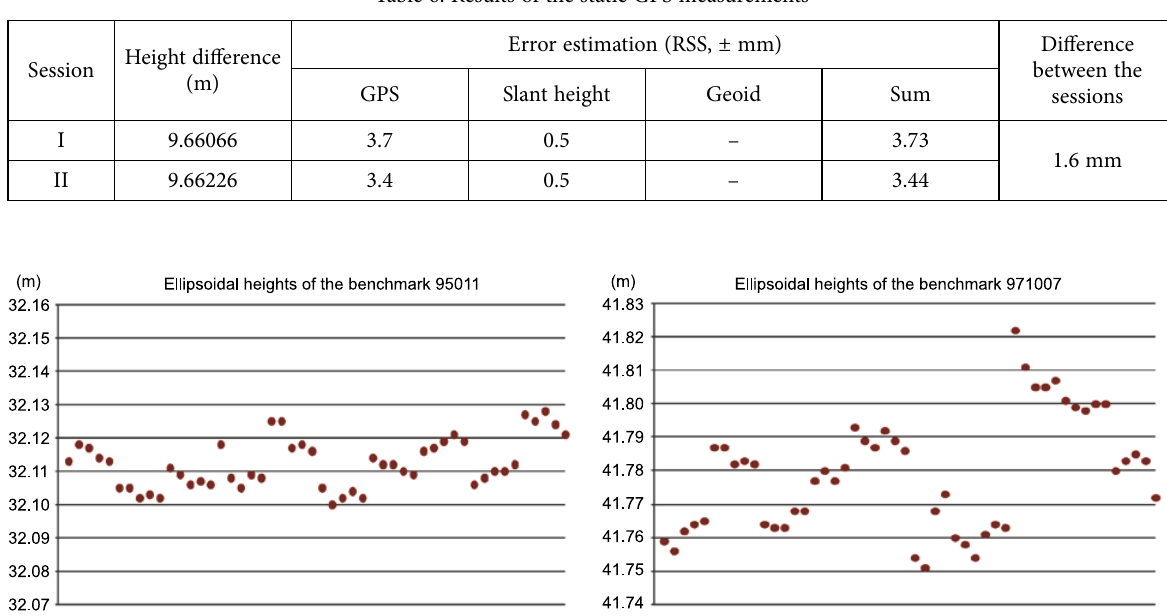
Fig. 4. Variations of the VRS height measurements on the